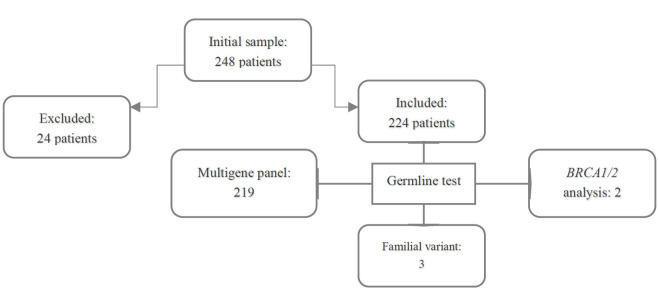
Cohort selection.